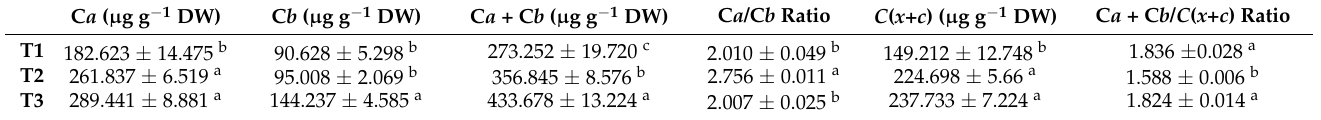
Table 3. Comparison of chlorophylls and carotenoid contents from methanolic extract of M. mala- bathricum L.